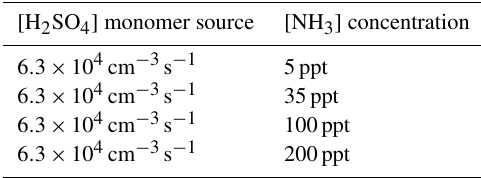
Table 2. Monomer concentrations used in